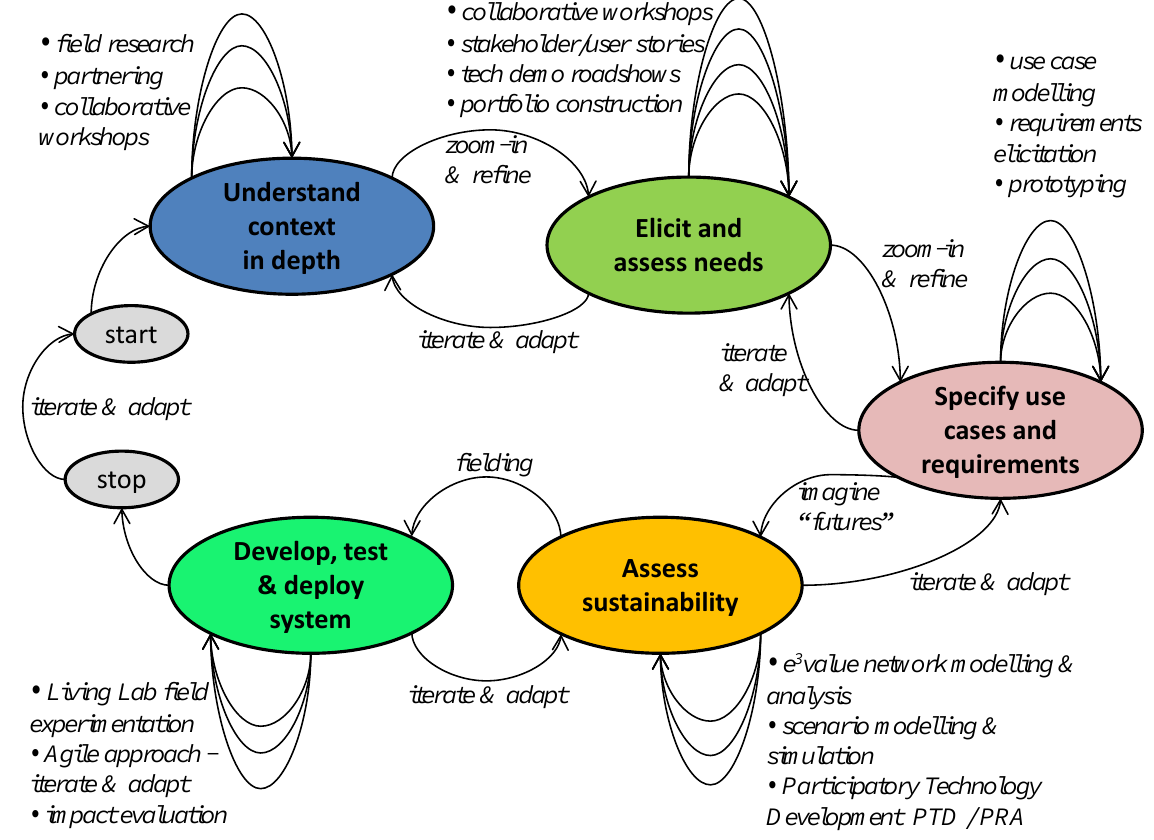
Figure 10. The collaborative-adaptive-iterative process model for our ICT4D Service Development framework, expressed in the form of an intention-strategy